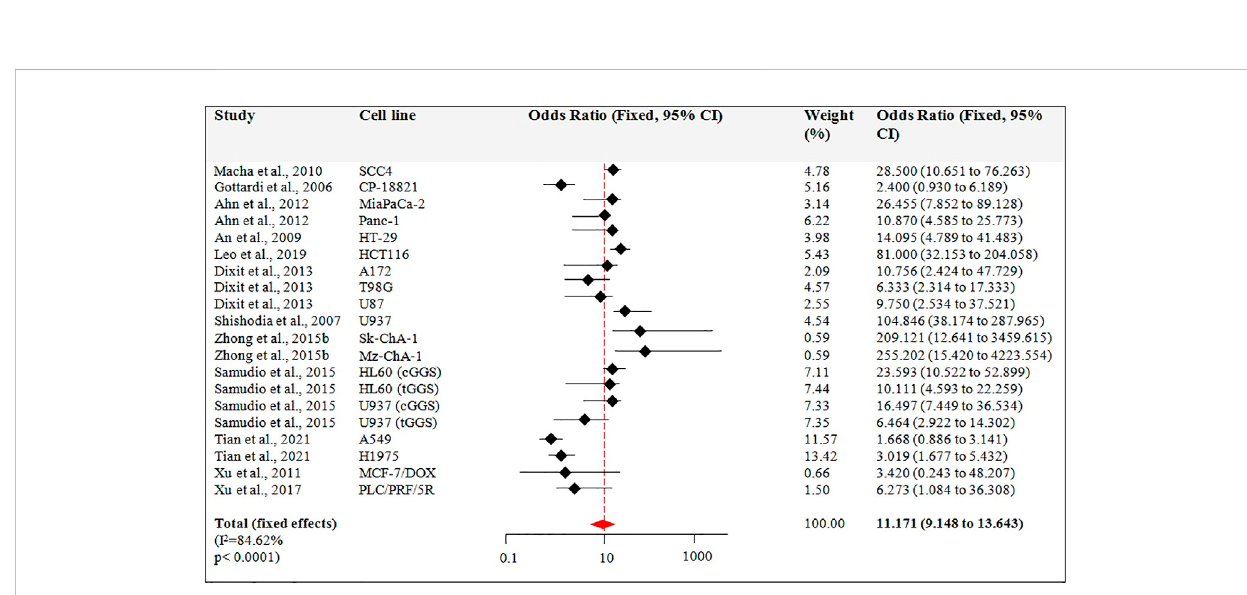
FIGURE 5 Guggulsterone (t > 24 h) versuscontrol odds ratio in cancer cells. Fixed effects meta-analysis was performed for the outcomesto compare data for Guggulsterone (t > 24 h) versus control and the odds ratio was determined.